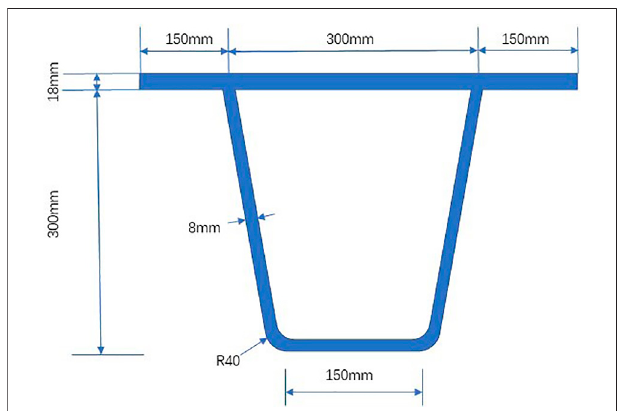
FIGURE 1 | The Simufact model of the U-rib stiffened plates.